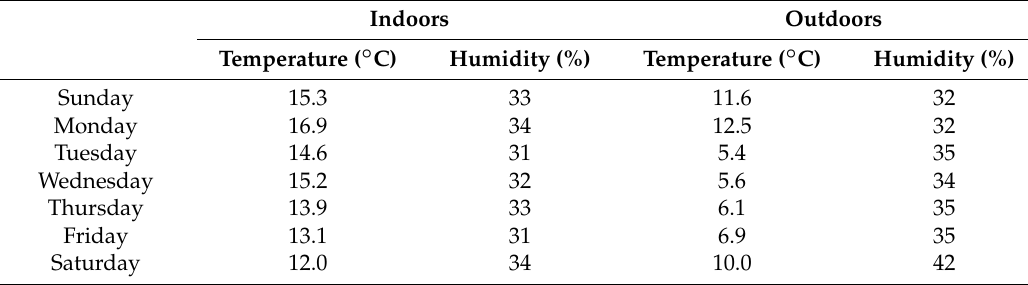
Table 2. Indoor and outdoor temperature and humidity for the seven study days.